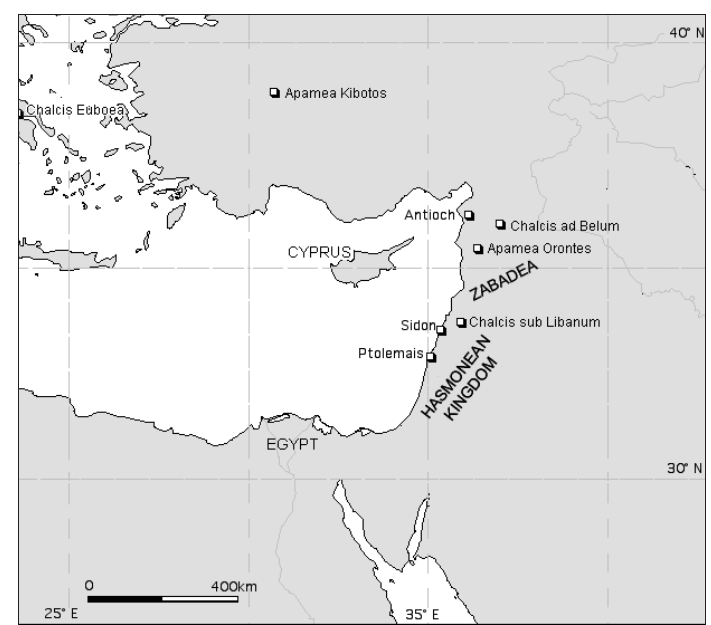
Fig. 3. Orientation map for the 198-92 B.C.